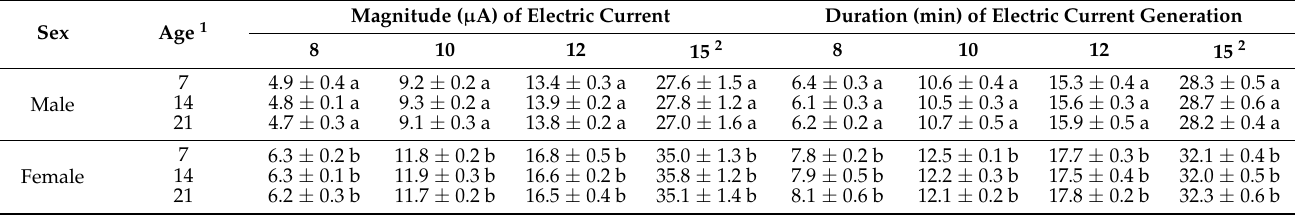
Table 3. Magnitude of electric current generated upon the attraction of male and female adult houseflies to the N-PIP of the EFP, and duration of the subsequent current generation by the flies captured by the